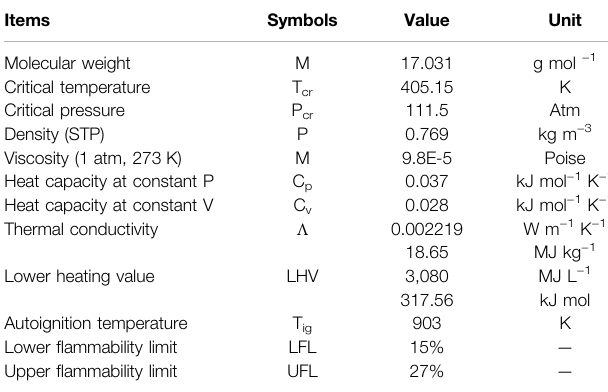
TABLE 1 | Chemical and physical properties of gaseous NH 3 (NCBI, 2021). Items